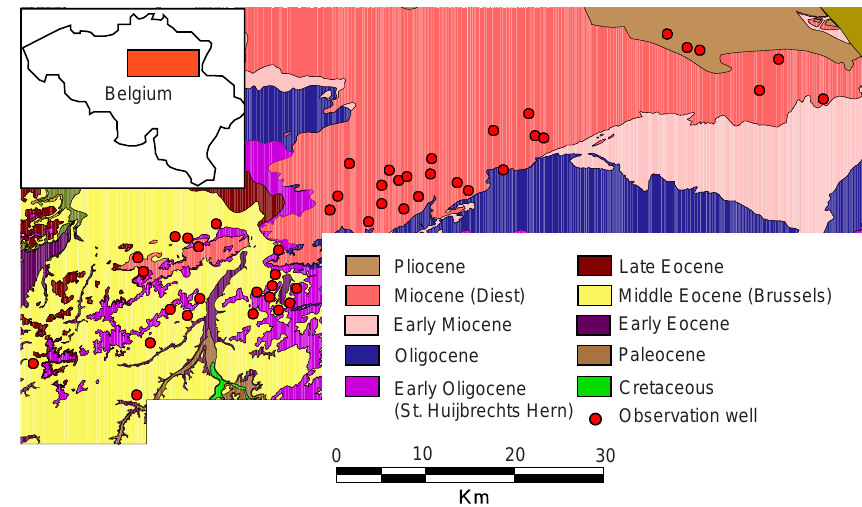
Fig. 5. Study area (after DOV, 2006).